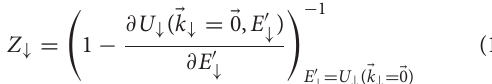
is not the case because the BCS is just a mean-field